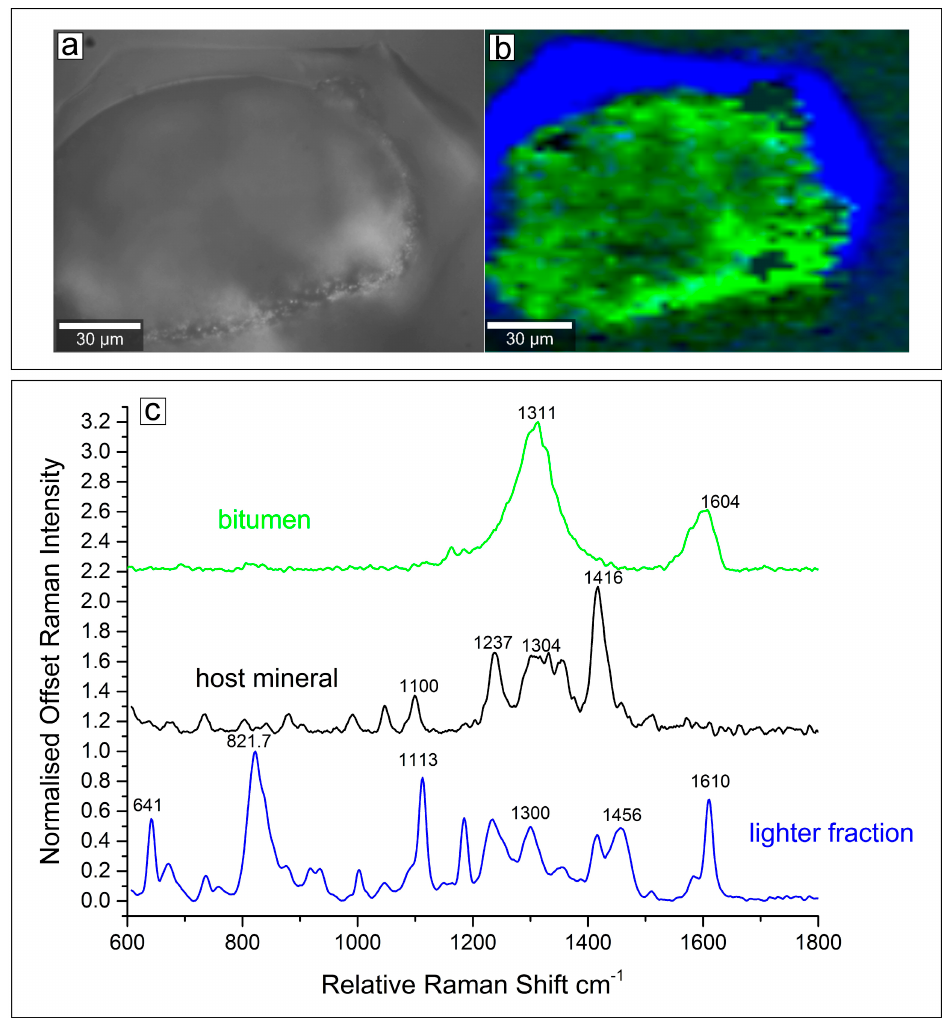
Figure 6. Bright field image of a Type 2 FI ( a ) and its corresponding Raman cluster map ( b ); The inclusion is defined by two coloured coded clusters. The green core corresponds to the bitumen; the surrounding blue zone relates to a lighter alkane–alkene phase; ( c ) Confocal Laser Raman Microscopy (CLRM) spectra for the Type 2 inclusion in ( a , b ) showing the principal peaks of bitumen and the lighter alkane–alkene phase as well as the host mineral.